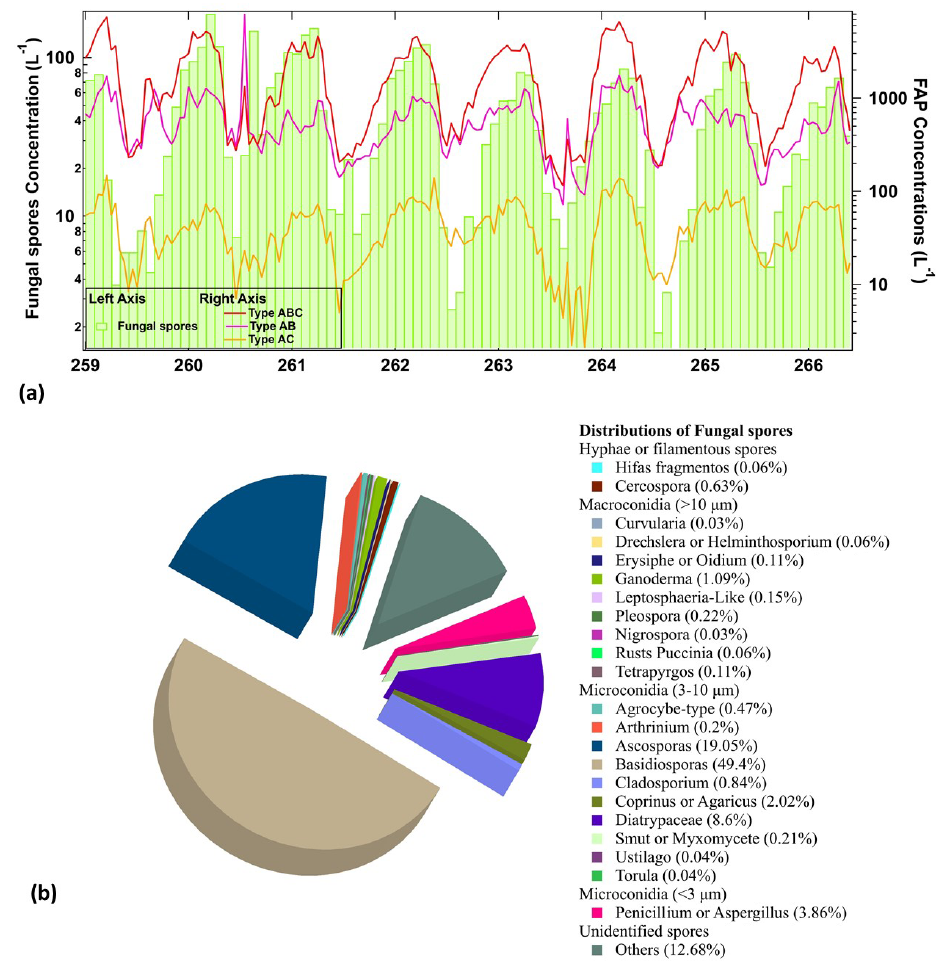
Figure 7. (a) Time series of the particle number concentrations of fungal spores (left axis), measured at the Department of Microbiology and Medical Zoology of Medical Sciences Campus at University of Puerto Rico, and the FAP types ABC, AB and AC (right axis) detected by WIBS. (b) Speciation of the outdoor fungal